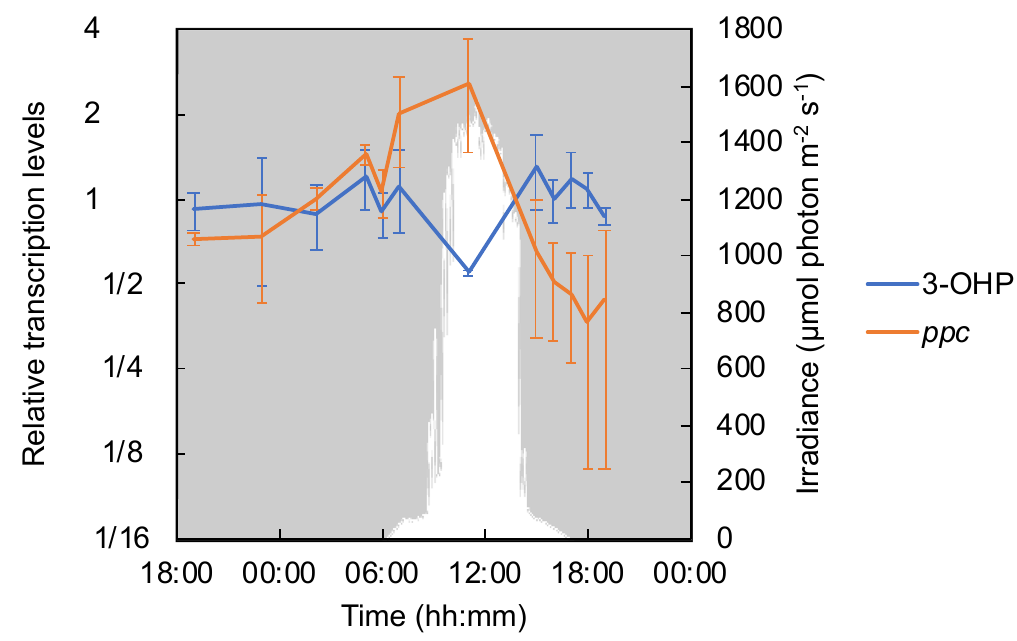
Figure 6. Relative transcription levels of genes encoding key enzymes of the 3-OHP bi-cycle and related enzymes of the anaplerotic pathway in cyanobacterial mats. The mean values of the relative transcription levels of key 3-OHP enzymes, i.e., malonyl-CoA reductase (Cagg_1256) and propionyl-CoA synthase (Cagg_3394), plus that of phosphoenolpyruvate carboxylase ( ppc , Cagg_0058 and 0399) are represented by a blue line and an orange line, respectively, with standard deviations. The downwelling photon irradiance (PAR; 400–700 nm) is indicated in white.